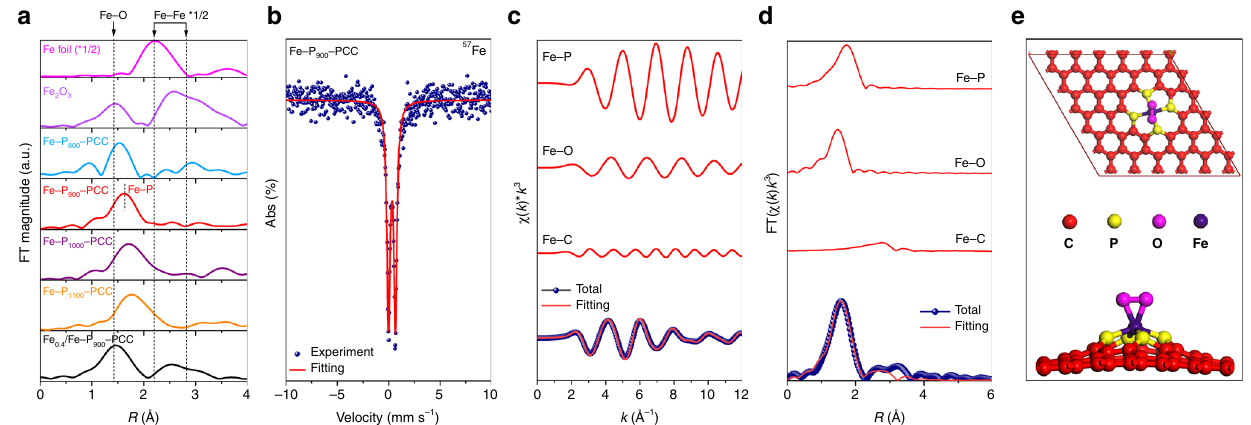
Fig. 3 Characterizations of Fe species. a EXAFS spectra of Fe-P x -PCC, Fe 0.4 /Fe-P 900 -PCC and reference materials (Fe foil and Fe 2 O 3 ). b 57 Fe Mössbauer spectrum of Fe-P 900 -PCC. c , d The experimental Fe K-edge EXAFS data (blue dot) and the fi tting curve (red line) of Fe-P 900 -PCC at k and R space, respectively. e Top and side views of optimized structural model of O 2 -Fe-P 4